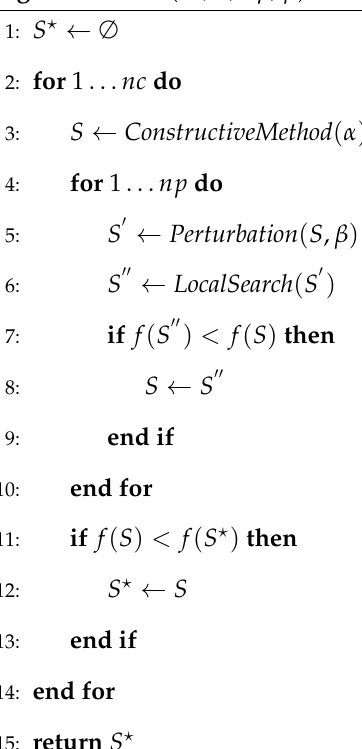
Algorithm 1 ILS( nc , α , np , β